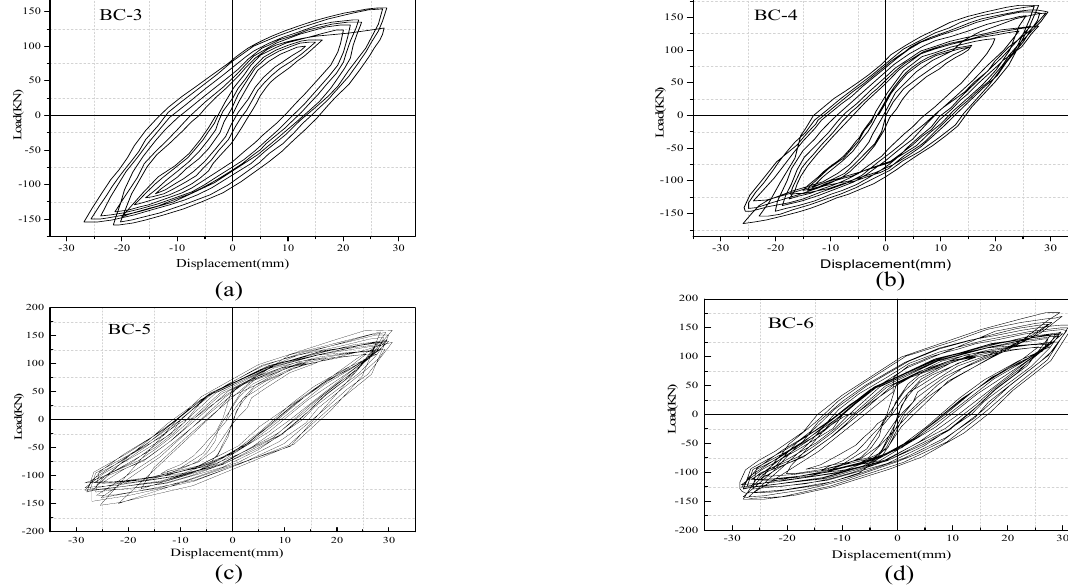
Figure 8. Hysteretic curve of strengthened specimens: ( a ) BC-3, ( b ) BC-4, ( c ) BC-5, ( d ) BC-6.